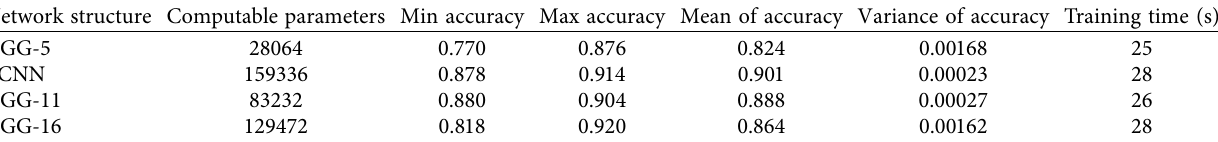
Table 5: Test results on the experimental data test set.